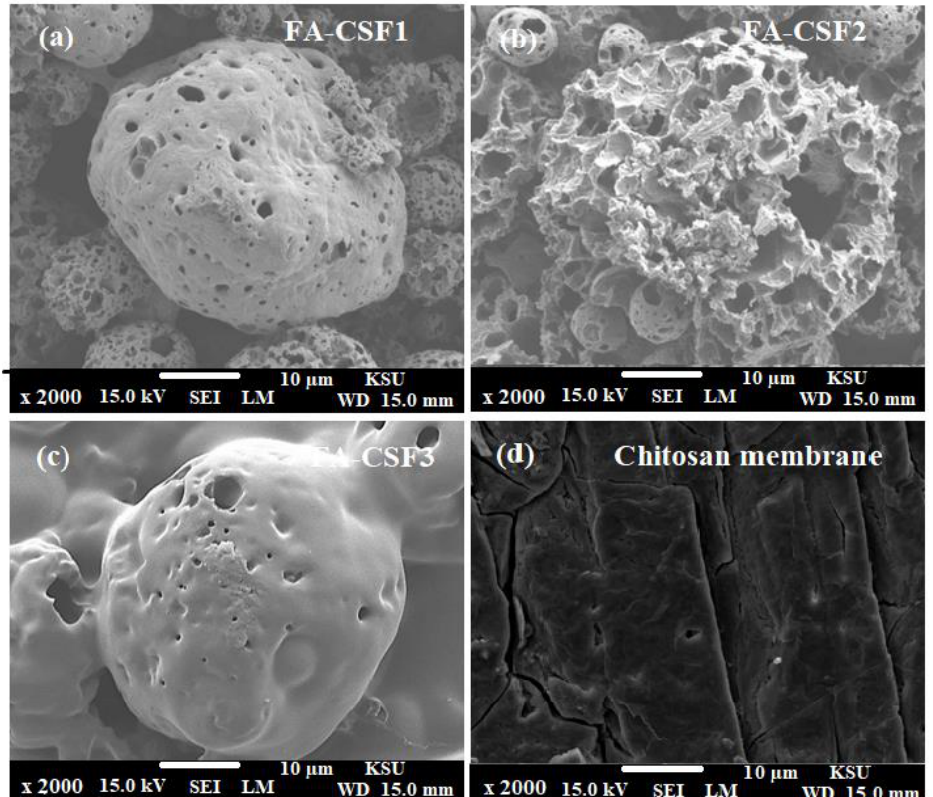
Figure 3. Scanning electron micrographs (SEM) for ( a ) FA-CSF1, ( b ) FA-CSF2, ( c ) FA-CSF3, and ( d ) Chitosan-based membrane (CSF) with a magnification ×2000.